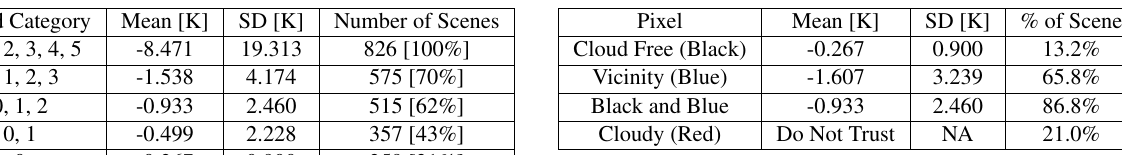
Table 3: Example of expected means and standard deviations